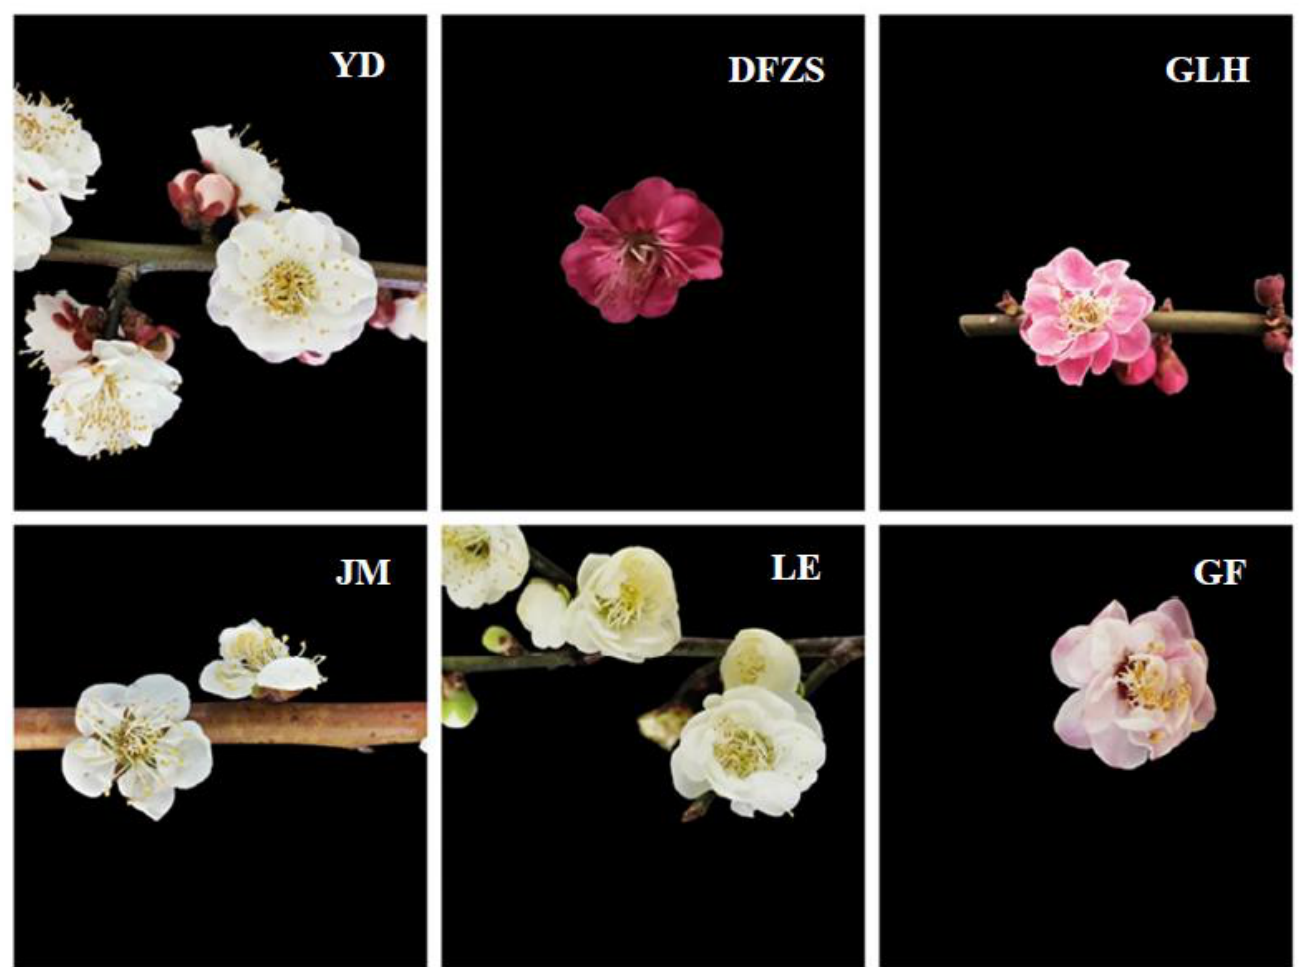
Figure 6. Pictures of six varieties of P. mume blossoms. YD (Yudie), DFZS (Dongfang Zhusha), GLH (Gulihong), JM (Jiangmei), LE (lve), GF (Gongfen).